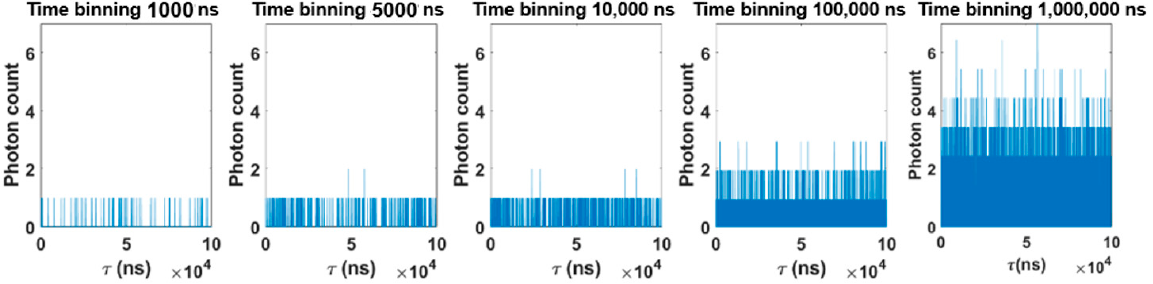
Figure 5. The effect of time binning in the range 10 3 –10 6 ns on photon count rate per time bin from data acquired from Rhodamine B solution at concentration 10 nM. The data was obtained from red channel (580/150 nm) at 800 nm excitation wavelength, 25 mW excitation intensity using 63× (NA 1.2) objective lens.